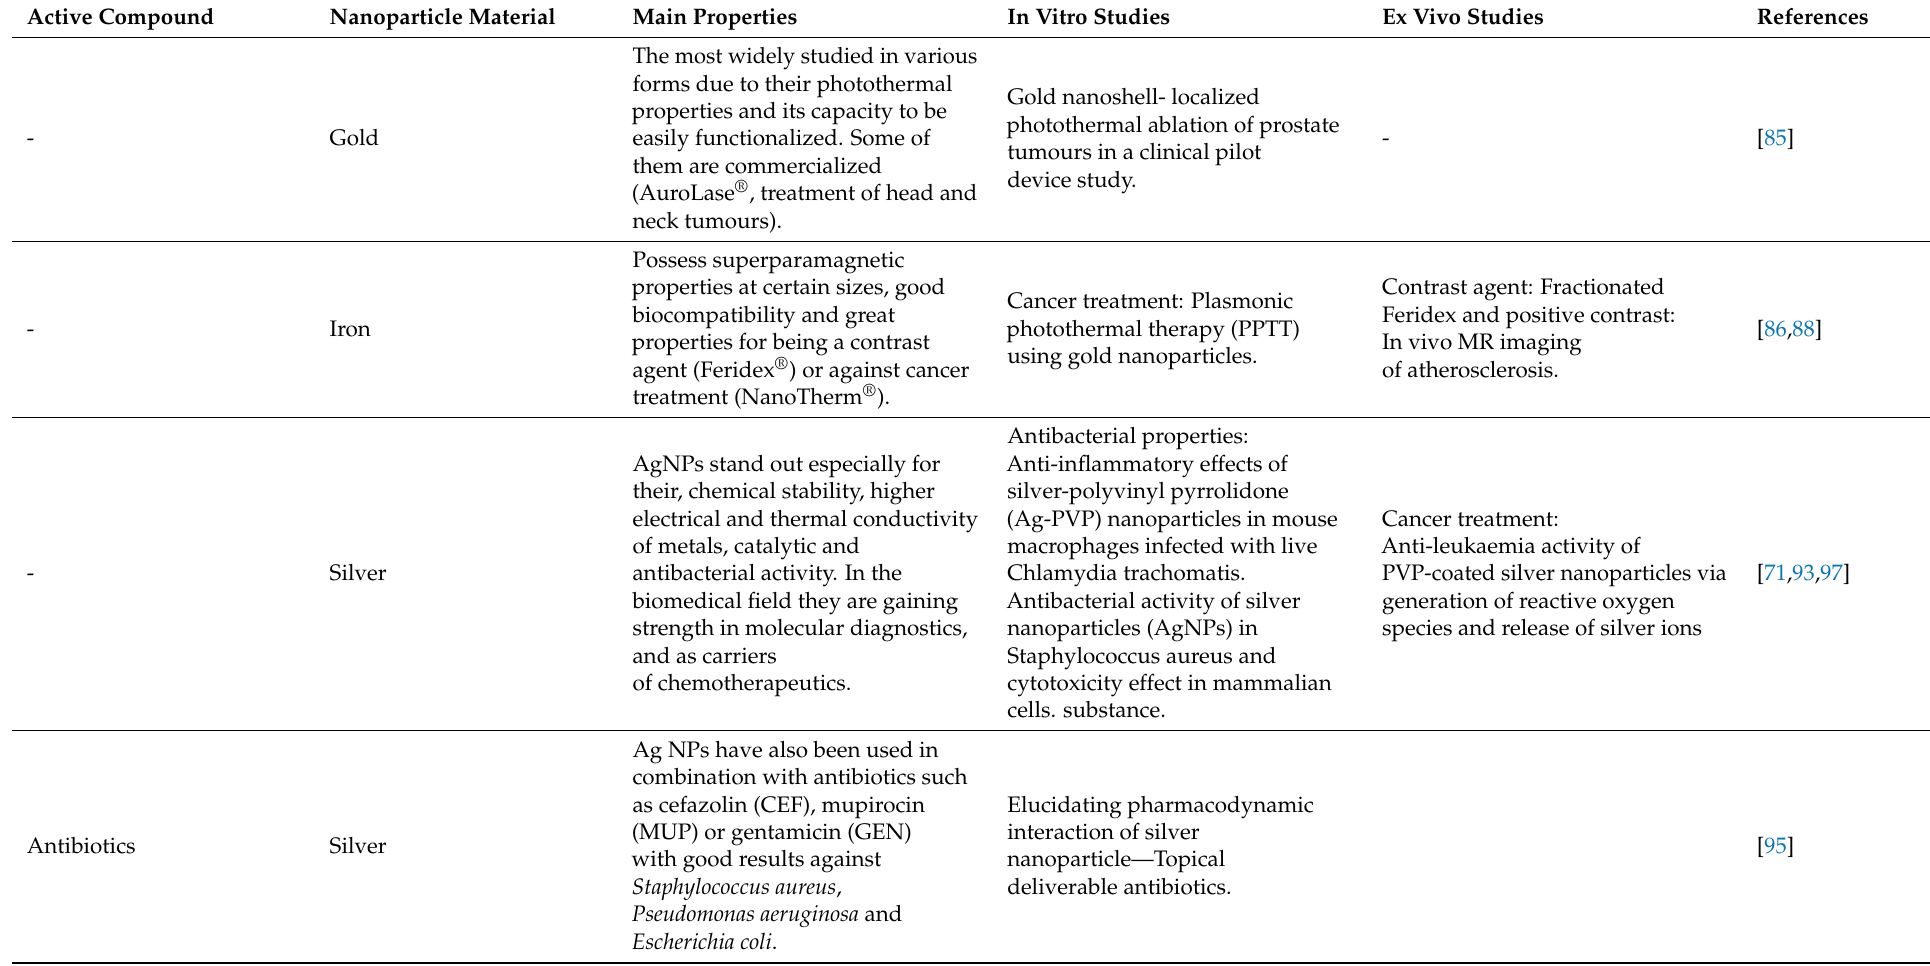
Table 2. Summary of recent advances and types of metal NPs in the medical